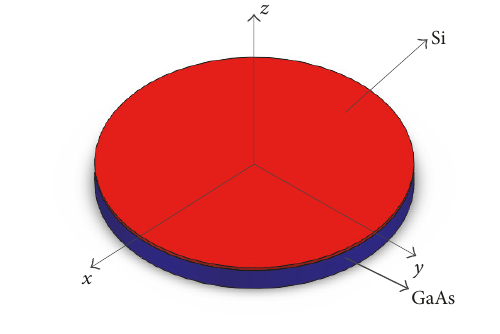
Figure 2: Overall schematic diagram of the disk structure.